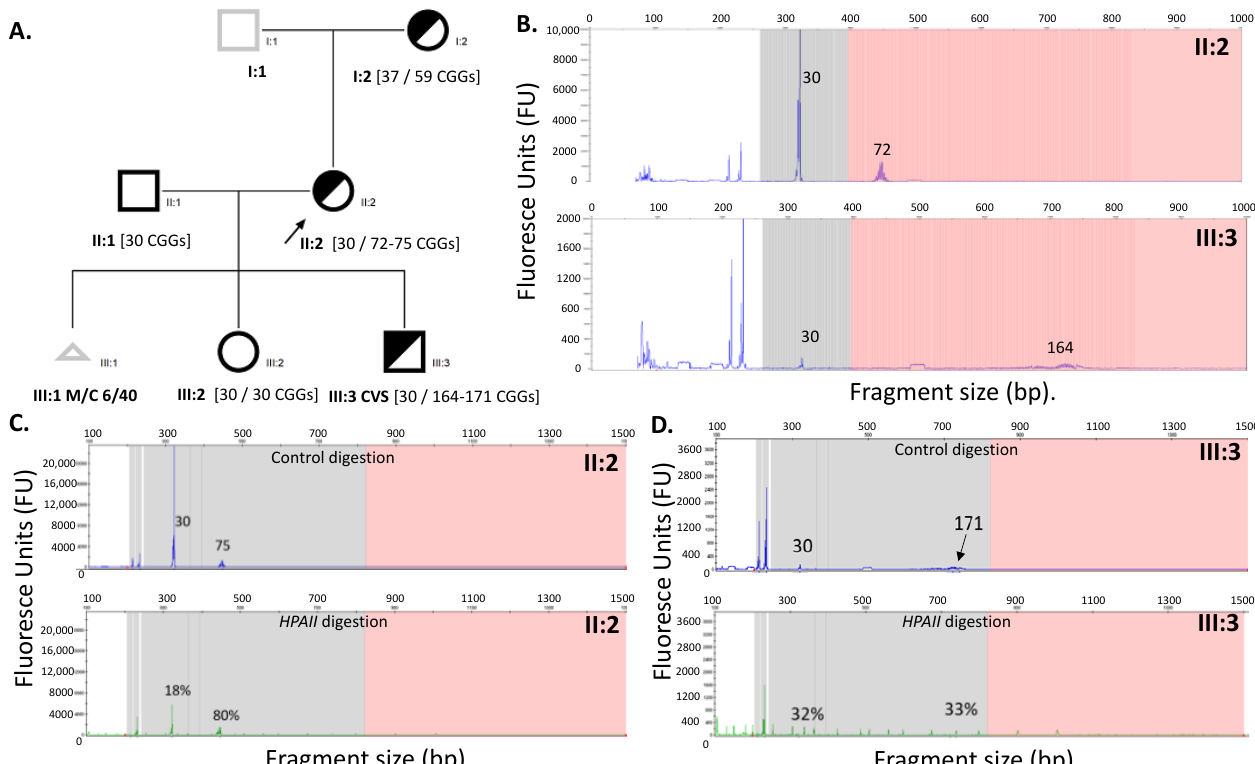
Figure 1. ( A ) Pedigree of the studied family with CGG sizing determined using an AmplideX TP-PCR. Males are represented by squares, females by circles and triangle sex unknown. A black outline indicates examined and half shaded indicates carrier. A black arrow indicates proband. III:1 Miscarriage at 6 of 40 weeks; ( B ) AmplideX TP-PCR CGG sizing, with no FM alleles detected in either III:3 male CVS or II:2 proband; ( C ) II:2 and ( D ) III:3 AmplideX mPCR, with the upper panel in blue representing CGG sizing based on control digestions and the lower panel in green representing relative methylation based on HpaII methylation sensitive restriction enzyme-based digestion followed by long-range PCR. No FM alleles are detected in either III:3 male CVS or II:2 female. Skewed methylation for the 75 CGG PM allele is suggested by 80% methylation. Note: numbers on each panel next to specific peaks indicate CGG sizes.